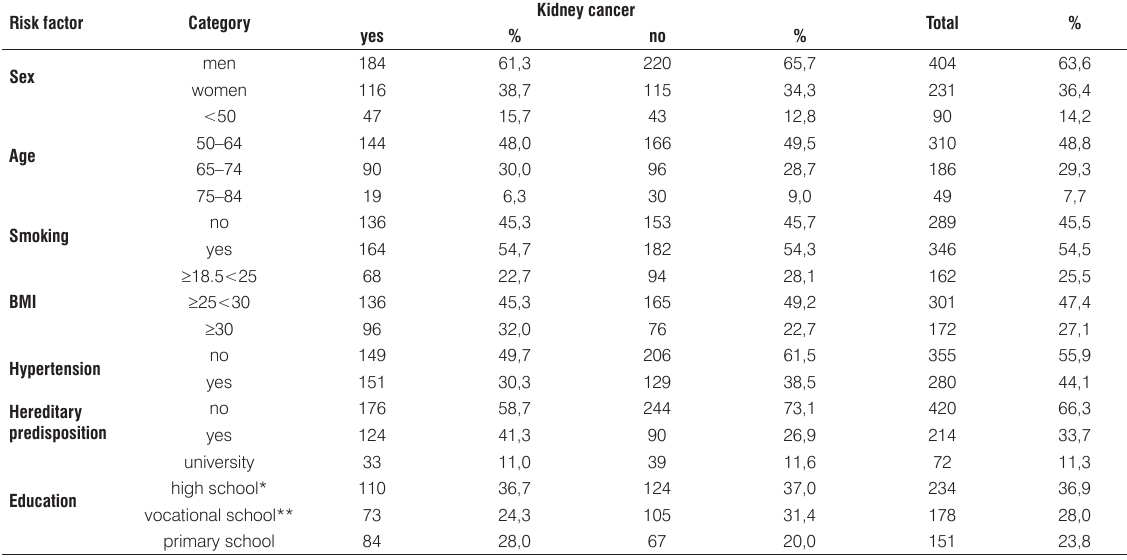
Table 1. Selected demographic characteristics of the study